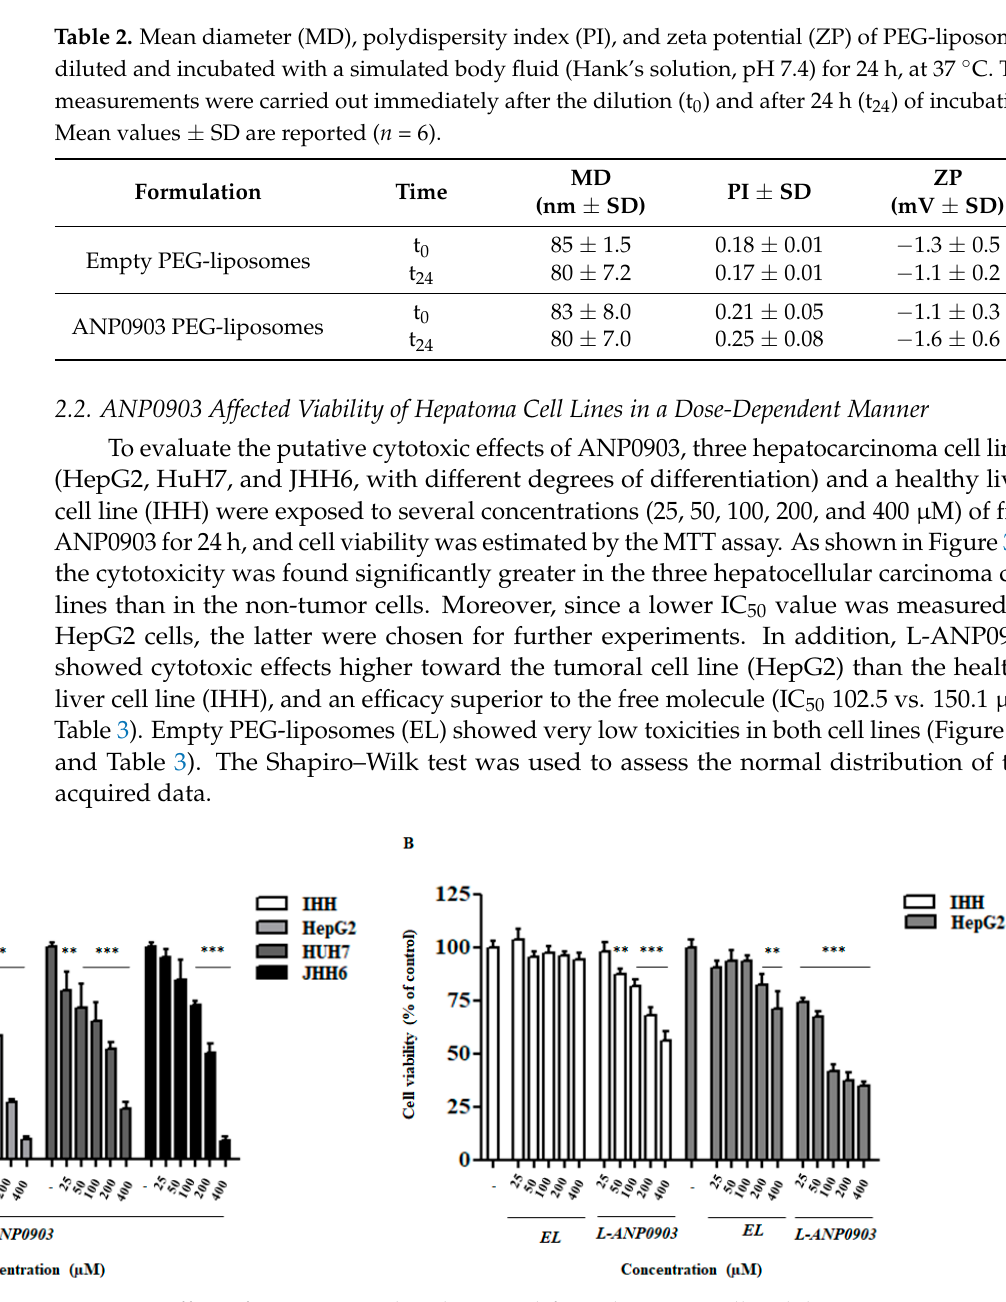
Figure 3. Effect of ANP0903 and its liposomal formulation on cell viability. MTT assays were performed ( A ) on normal hepatocytes (IHH) and on three different hepatoma cell lines (HepG2, HUH7, and JHH6) treated for 24 h with ANP0903 at indicated concentrations (25–400 µM) and ( B ) on IHH and on HepG2 cells treated for 24 h with ANP0903 PEG-liposomes (L-ANP0903) at indicated con- centrations (25–400 µM) or empty PEG-liposomes (EL), which were subjected to the same dilutions as ANP0903 and L-ANP0903 to reach the above concentrations. Cell viability was expressed as a percentage relative to control cells treated with vehicle (indicated with minus sign or with CTRL abbreviation). All data are expressed as means ± Standard Error (SE) of three experiments, each performed in triplicate, and statistical significance was evaluated by one-way ANOVA followed by Dunnett’s post hoc test (* p <0.05, ** p <0.01, *** p <0.001 vs. CTRL). Table 3. The half-maximal inhibitory concentration (IC 50 ) values of ANP0903 and of its liposomal formulation (L-ANP0903) tested on human hepatocarcinoma cell lines. Empty PEG-liposomes (EL) were tested as a control to evaluate the cytotoxicity of the nanocarrier. Cell Line